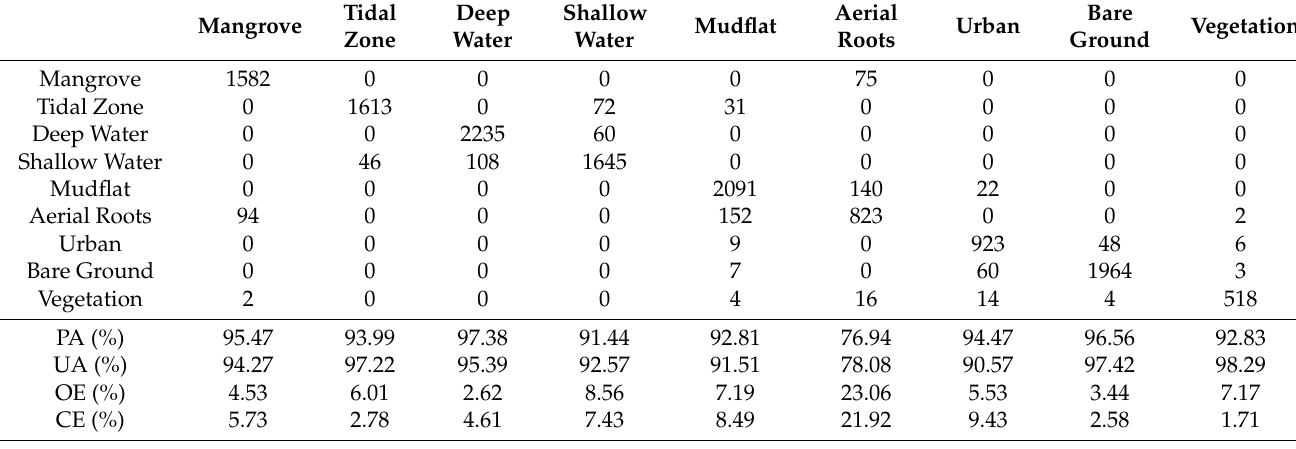
Table 3. Average confusion matrix of mangrove ecosystem mapping using the random forest (RF) algorithm and a combination of the Sentinel-1 and Sentinel-2 satellite images processed within the Google Earth Engine (GEE) platform.